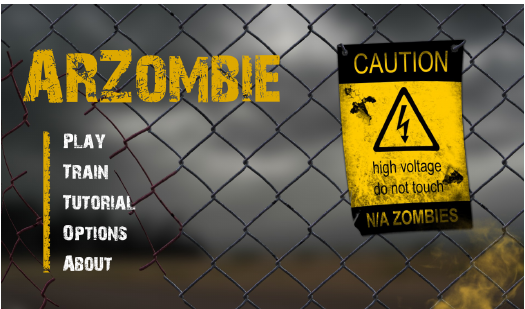
Figure 7: ARZombie main